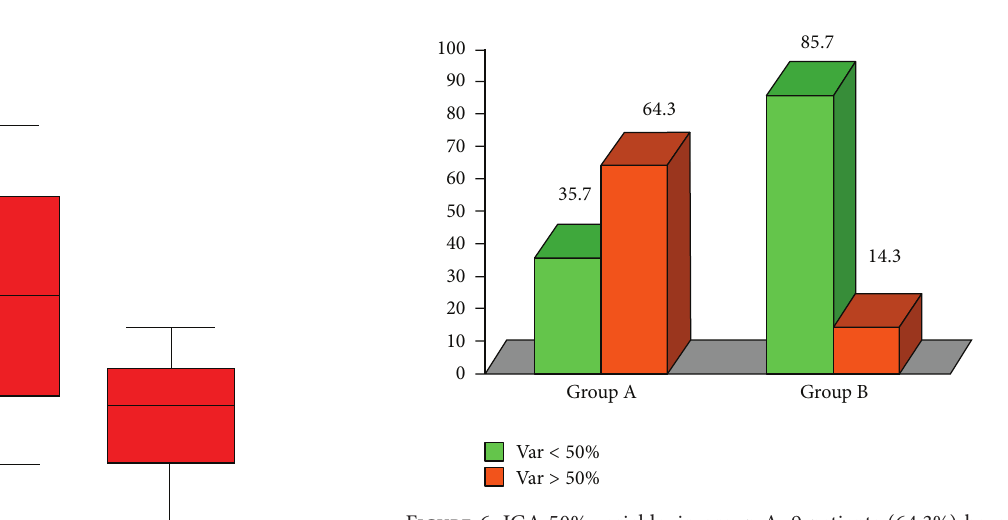
Figure 6: IGA 50% variable: in group A, 9 patients (64.3%) have had a reduction superior or equal to 50% after therapy; in group B, 2 patients (14.3%) have had a reduction superior or equal to 50%.